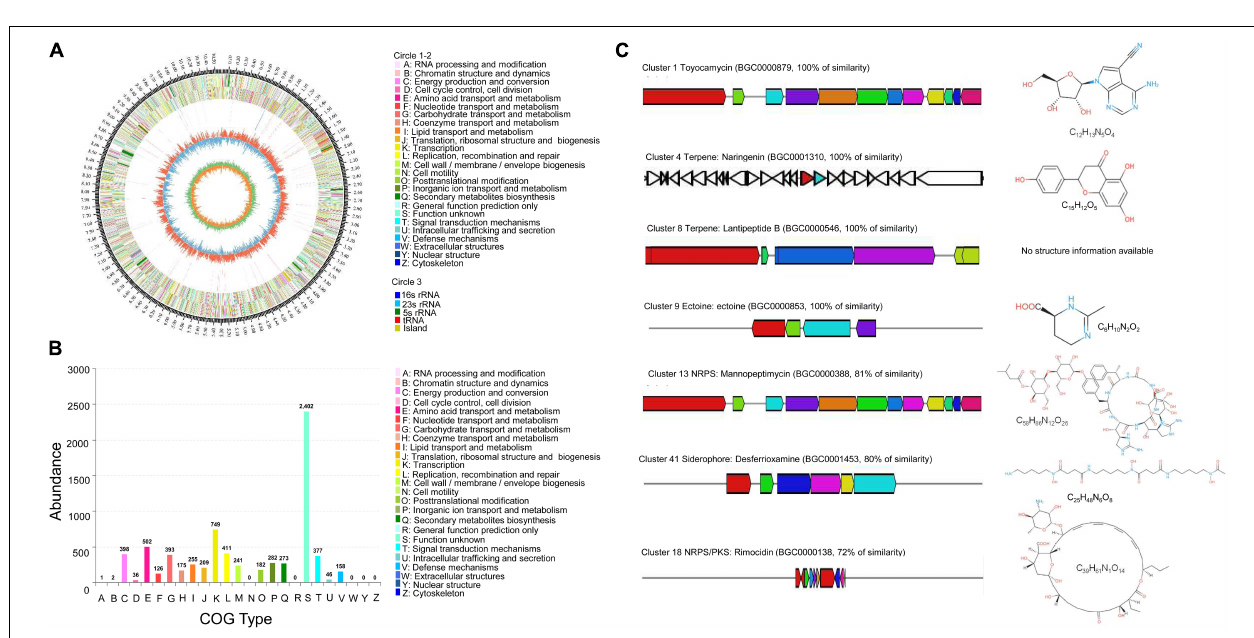
FIGURE 7 | Expression levels of the selected MaMAPK1 (A) and Ma β -1,3-Glu (B) in banana roots after treatment with Streptomyces BITDG-11 at different time points. T1–T3 represent different treatment groups as in the description in Figure 5 . Error bars indicate standard errors of the means of three repeated experiments. Different letters indicate significant differences in comparison with the medium treatment group at the same time points (LSD’s multiple range test, p < 0.05).